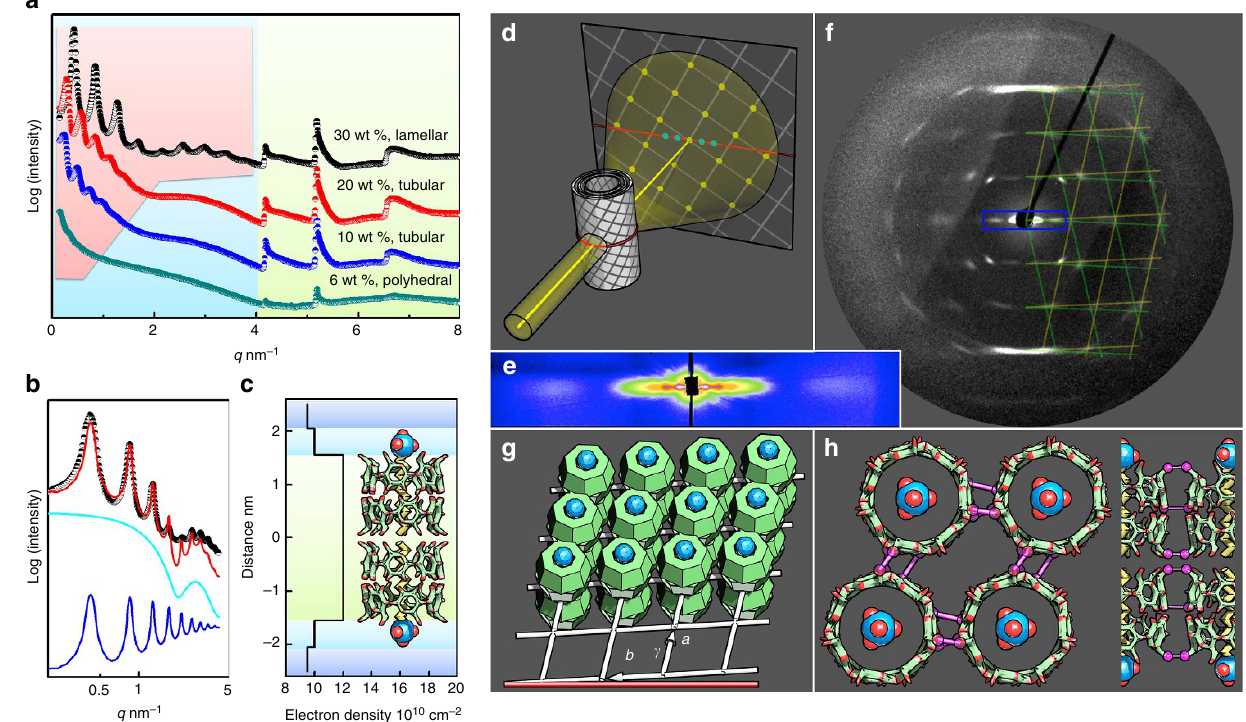
Figure 4 | X-ray scattering of the SDS@2 b -CD structures. ( a ) SAXS curves of the lamellar, tubular and polyhedral phases with different SDS@2 b -CD concentrations. The curves (vertically shifted for clarity) are divided into pink, cyan (overlapping with pink) and green regions, corresponding to lamellar structure factor, form factor and in-plane crystallinity, respectively. ( b ) The SAXS curve (30wt%, black dots) up to 4nm (cid:2) 1 is fitted by a bilayer form factor (cyan line) and lamellar structure factor (blue line) with a good result (red line). The cyan and blue lines are vertically shifted for clarity. ( c ) The electron density profile across the bilayer. The thickness 3.1nm and electron density of the core part (the green region) matches a vertical stack of 4 b -CD molecules (0.75nm high), the thickness and electron density of the outer part suggests two SDS molecules with their tails threading the CD cavities and headgroups pointing outwards. Threaded b -CD molecules usually stack in a head-to-head fashion to maximize the inter-CD H-bonding along the threading direction. ( d ) A scheme of wide-angel X-ray scattering of aligned multilamellar tubes with in-plane crystallinity. ( e ) Scattering pattern along the equator at small angel, corresponding to the blue box in f . ( f ) Scattering pattern at large angel is super-positioned by the mirrored yellow and green grids. ( g ) The in-plane lattice with a rhombic unit cell, a ¼ b ¼ 1.52nm, g ¼ 104 (cid:2) and the b axis-to-equator angel ¼ 3 (cid:2) . ( h ) Top and side views of the SDS@2 b -CD lattice, highlighting the possible, inter-CD H-bonds